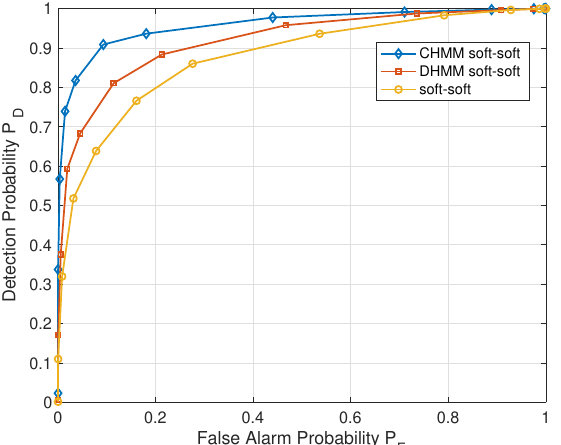
Figure 6. ROC of CHMM soft–soft scheme (the proposed CHMM-based heterogeneous two-stage fusion sensing scheme), DHMM soft–soft scheme and non-CHMM soft–soft scheme.